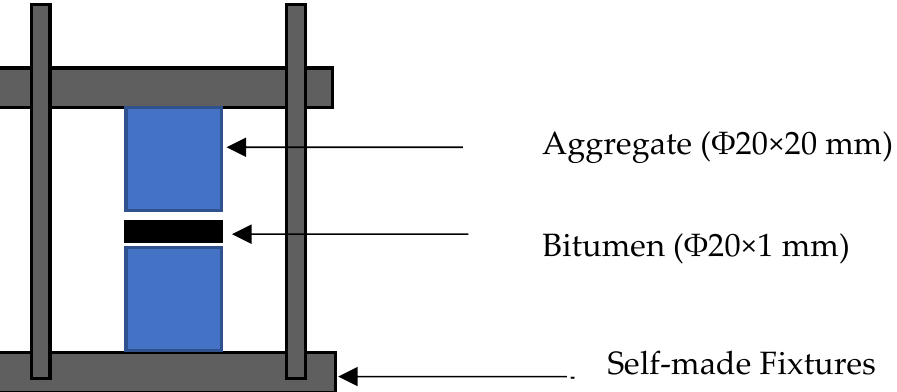
Figure 2. Schematic of the preparation of asphalt mastic–aggregate interface specimens. Table 6. Specimen designs and names of asphalt mastic–aggregate interfaces.